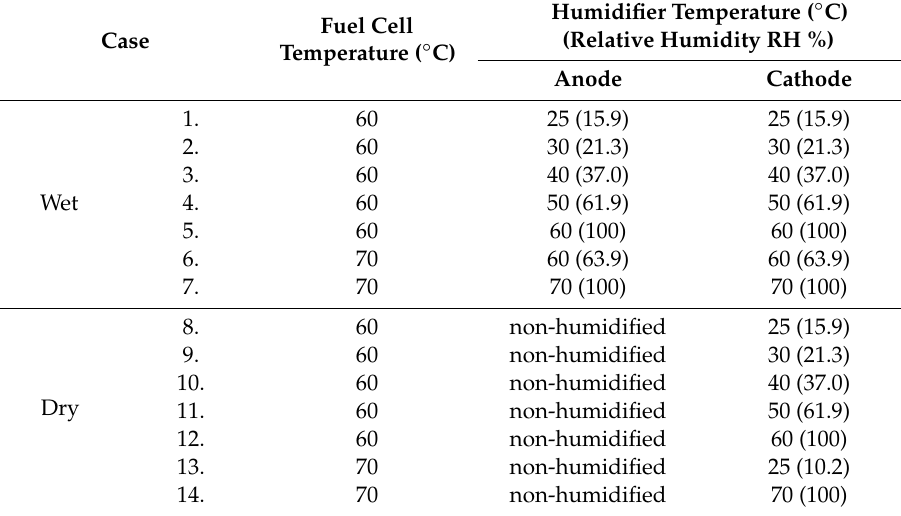
Table 1. Temperatures of the fuel cell and anode / cathode